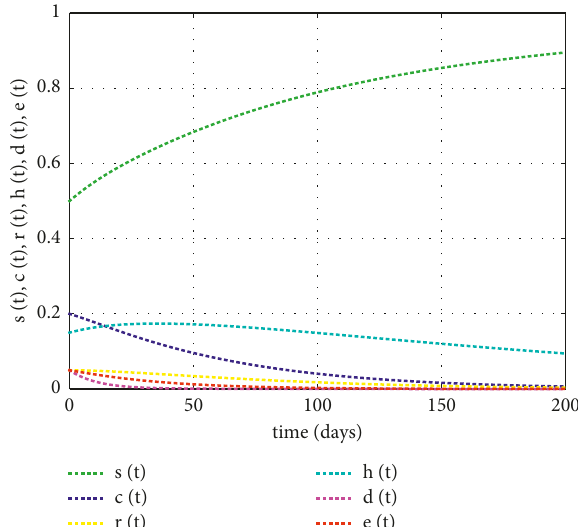
Figure 5: Numerical simulations of dynamics of populations with extinction of infections in the population R